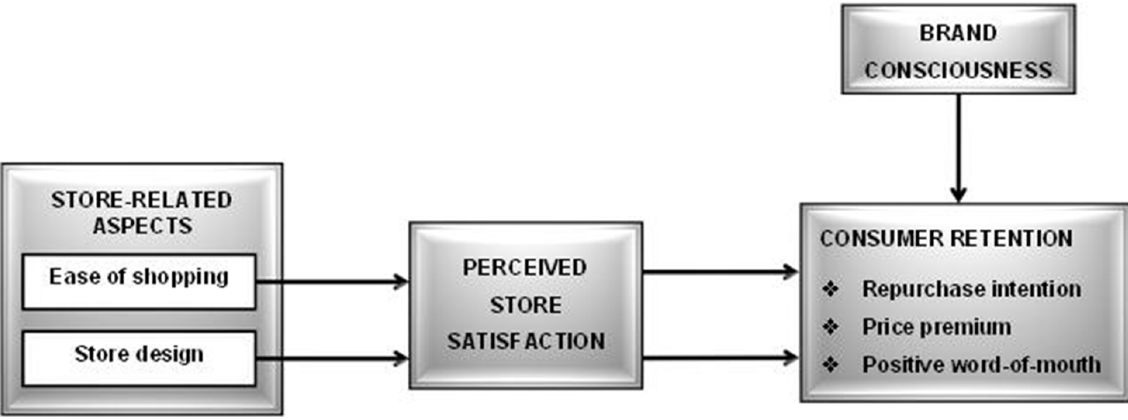
Figure 1 . Proposed Model Path